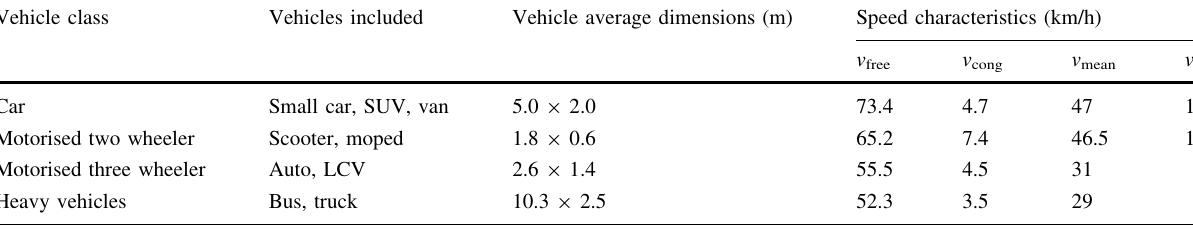
Table 2 Vehicle classes, physical dimensions and speed characteristics Vehicle